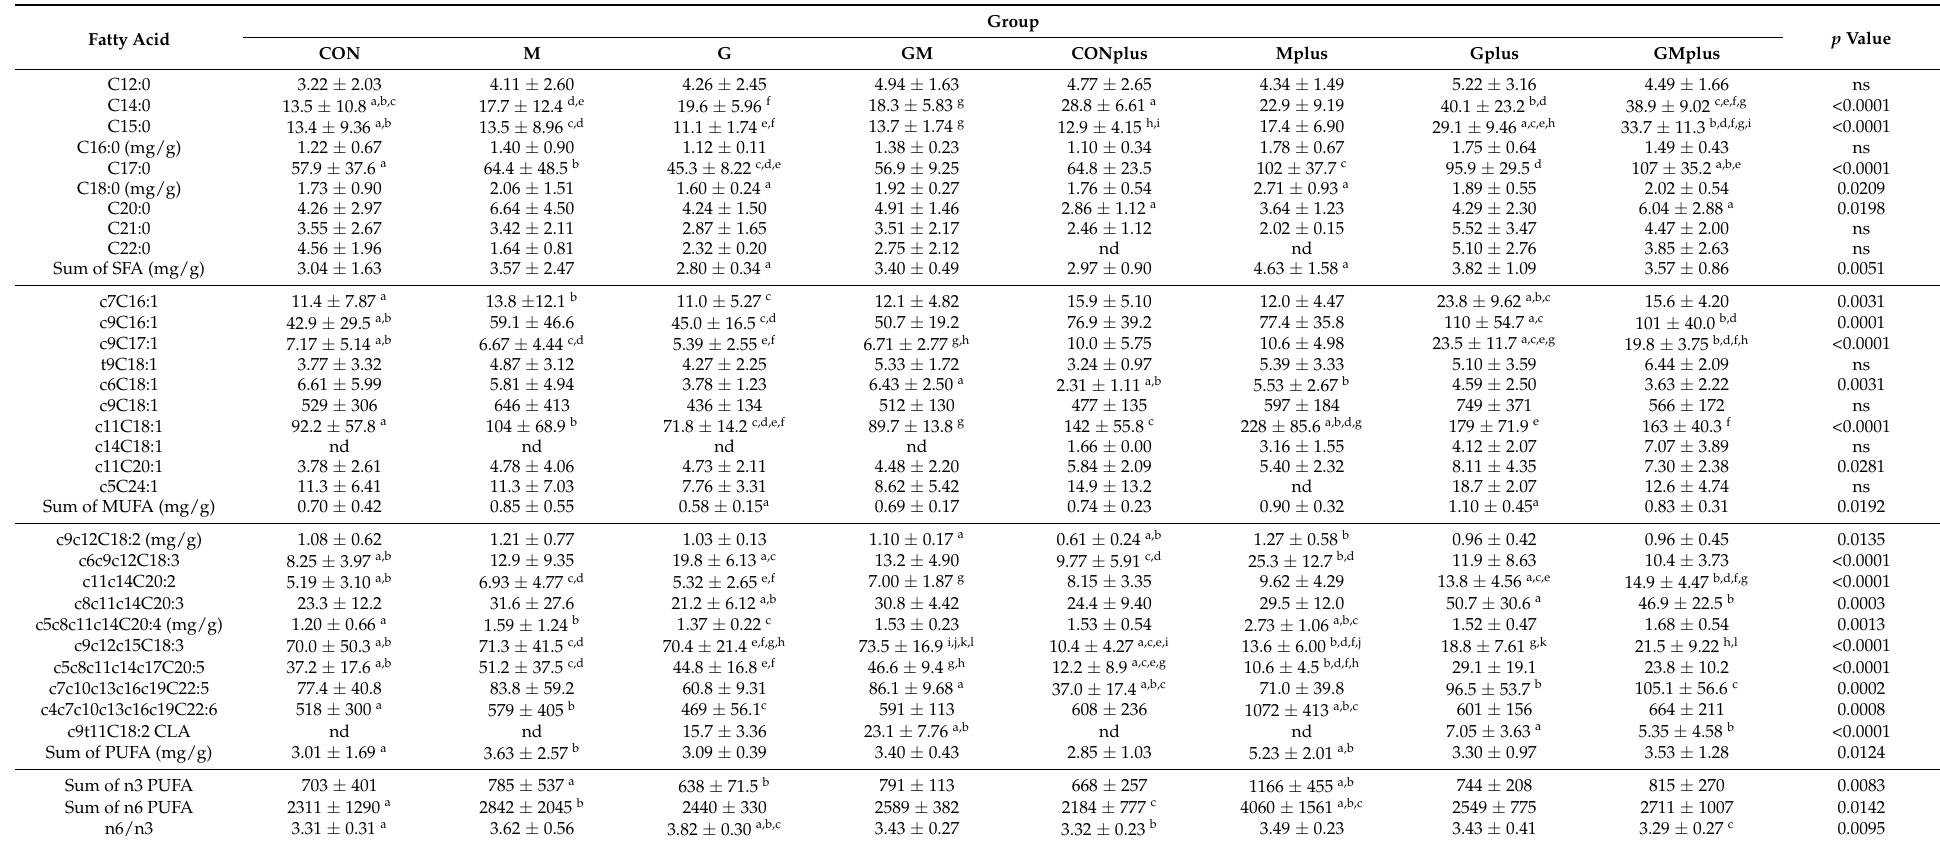
Table 1. Fatty acids content in hepatic microsomes of experimental groups ( µ g/g of